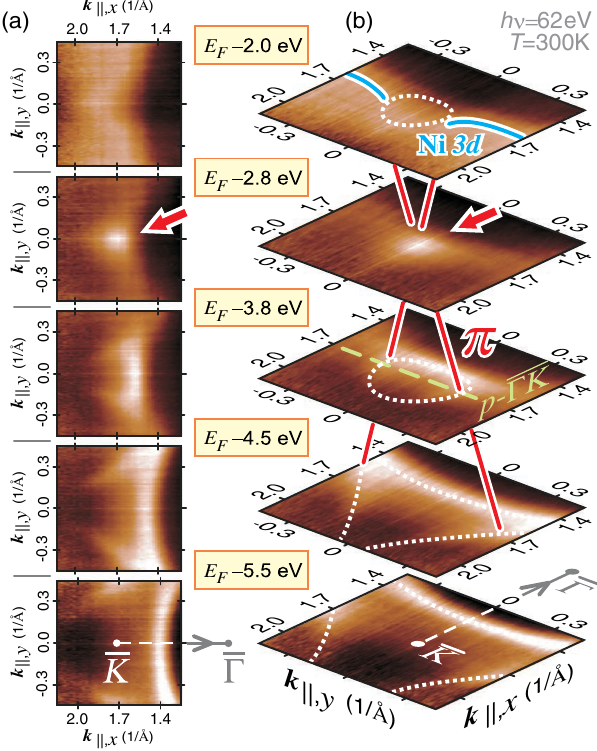
FIG. 3. Full ARPES mapping of the (cid:1) band in graphene on Ni(111) around (cid:1) K . (a) Constant energy surfaces reveal character- istic triangular contours of the (cid:1) band. The Dirac point (red arrow) is clearly observable at 2.8 eV binding energy. (b) Same as (a) but in isometric representation and with a three- dimensional sketch of the band structure.